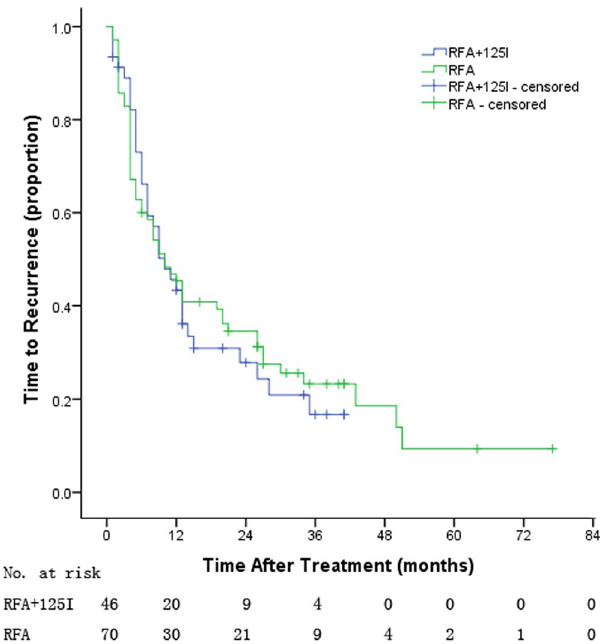
Figure 2. The time to recurrence of the two groups patients.